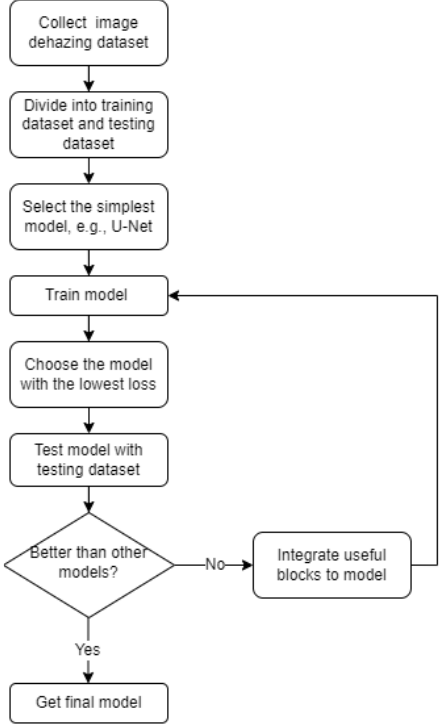
Figure 7. The workflow of the proposed dehazing-model generation.